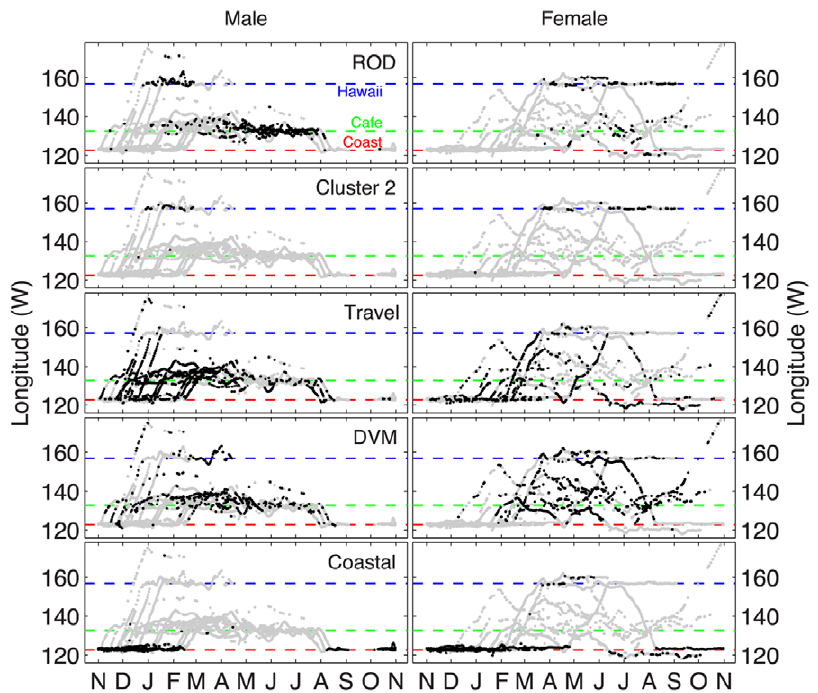
Figure 4. White shark seasonal and spatial patterns corresponding to each behavioral mode for males and females. The dotted lines represent the coast of California (red; near 122 u W), the Cafe´ (green; near 135 u W) and Hawaii (blue; near 156 u W) respectively. All longitude estimates for the entire male (left panels) and female (right panels) dataset are shown in grey in the background with only the relevant data for each cluster and sex highlighted in black.